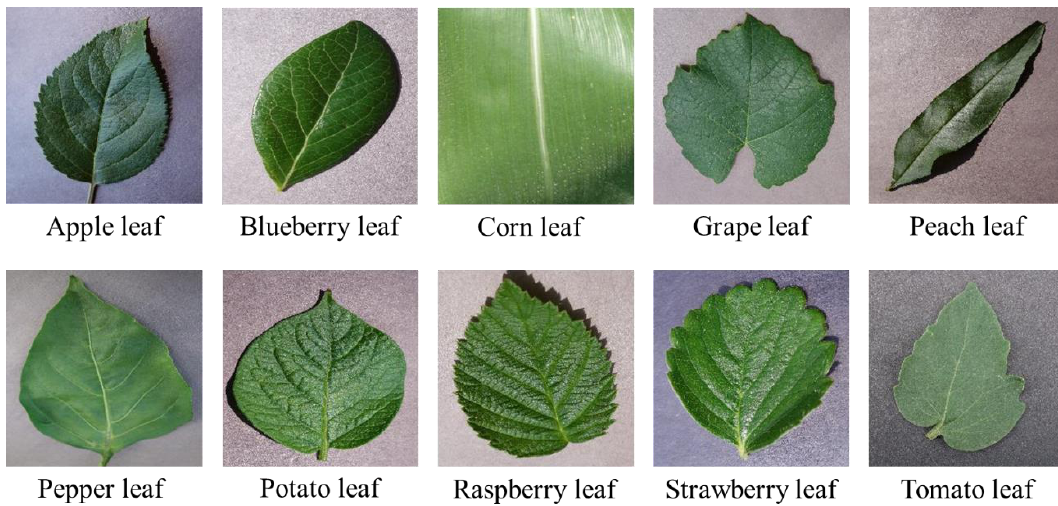
Figure 2. Samples of the plant leaf dataset (from PlantVillage).